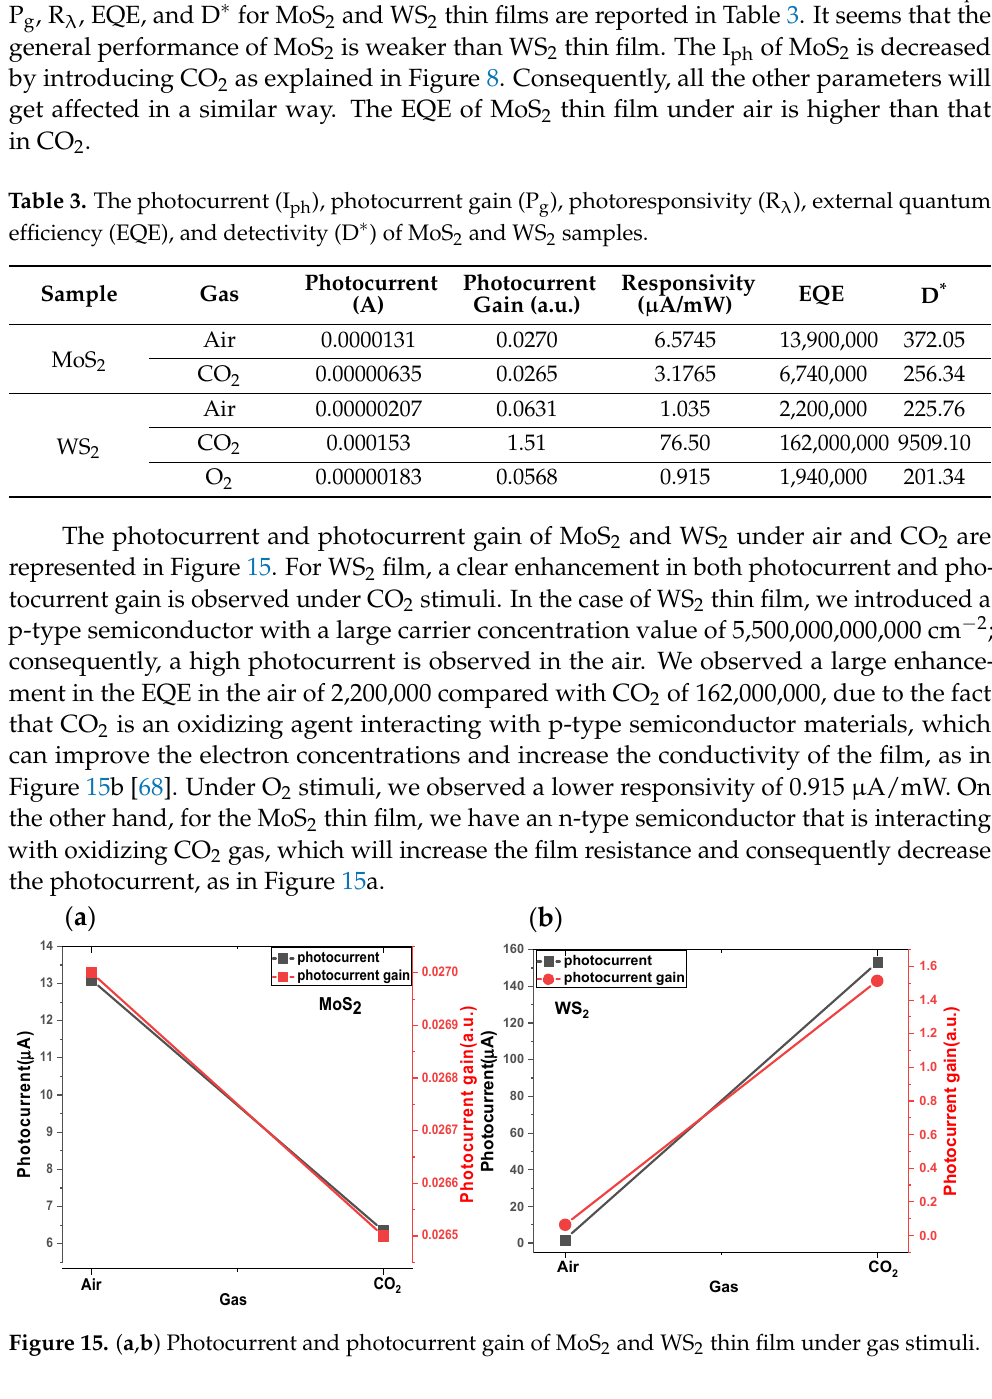
2 and WS 2 thin film under gas